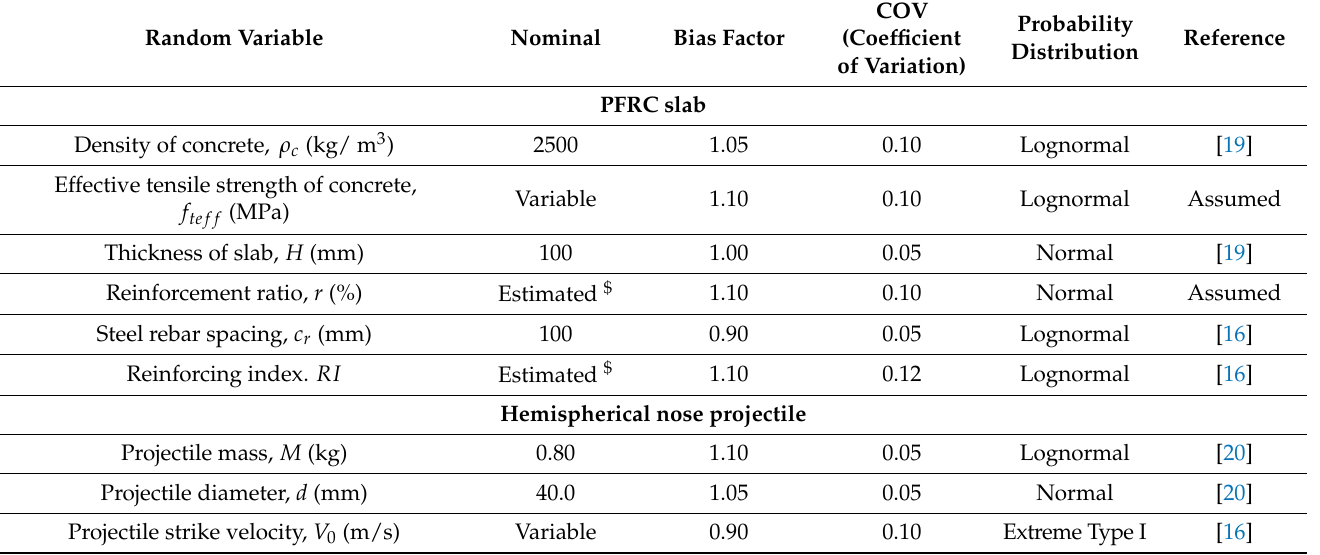
Table 2. Random variables and statistical